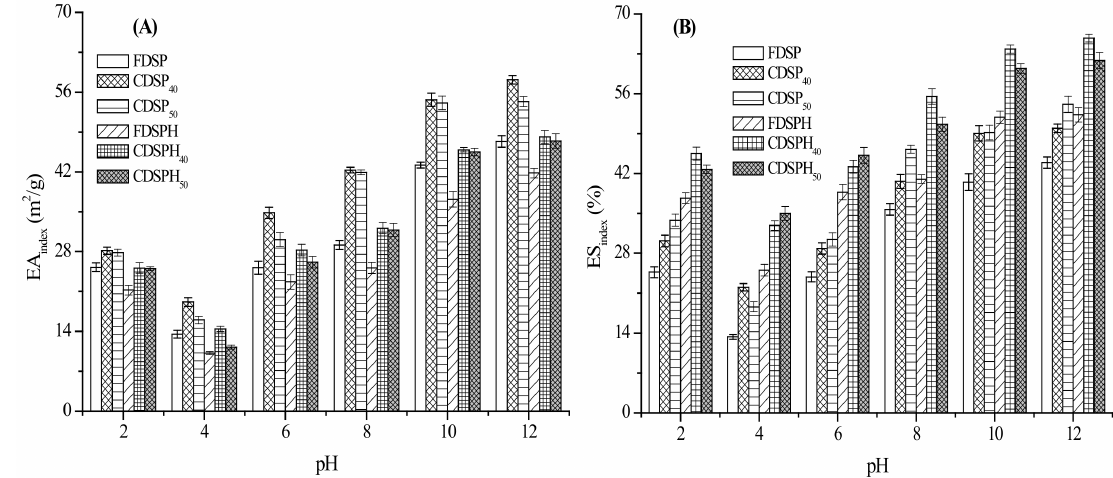
Figure 3. EA index ( A ) and ES index ( B ) of freeze- and convectively-dried SP and SPH. Results also showed that SPHs possessed low EA index , but high ES index values com- pared with the respective SP isolates ( p < 0.05). The low EA index of SPHs can be associated with the formation of small-sized hydrolysates (peptides) during the enzymolysis. These hydrolysates were diffused and adsorbed rapidly at oil/H 2 O interface, but thereafter ex- hibited reduced efficiency in decreasing interfacial tension because they were not unfolded and/or rearranged at the interface, which reduced the EA index [39]. Moreover, a higher ES index value of SPHs suggested that these hydrolysates were more stable at oil-H 2 O in- terface and were sufficiently flexible to generate good interfacial films, contributing to enhancing emulsion stability [35]. In literature, Elavarasan and Shamasundar [40], and Ghribi et al. [27] indicated that oven drying resulted in greater EA index and ES index of protein/hydrolysate than the respective freeze-dried samples, which was in agreement with the noted outcomes in this study. Contrarily, Brishti et al. [16], and Musa et al.